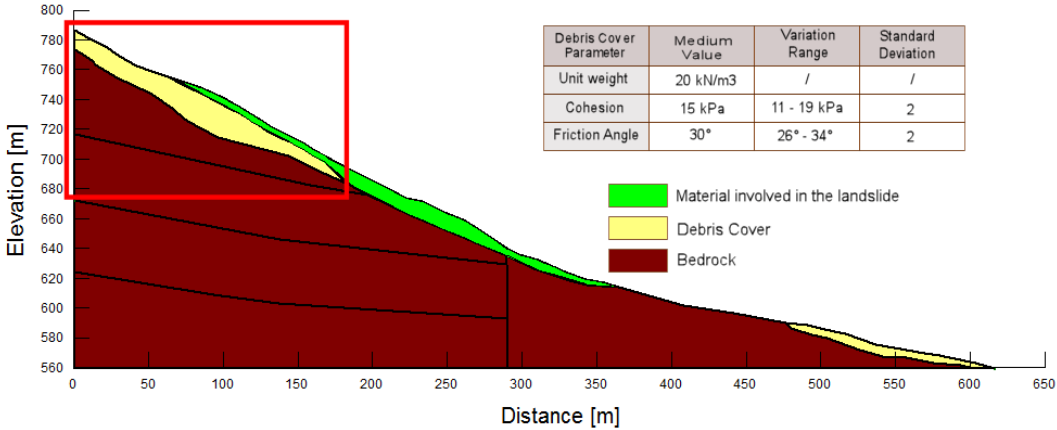
Fig. 10. Results of the coupled seepage and stability back analysis of the Val di Maso landslide that occurred after the November 2010 event. Red inset indicates the portion of the slope investigated in the forecasting